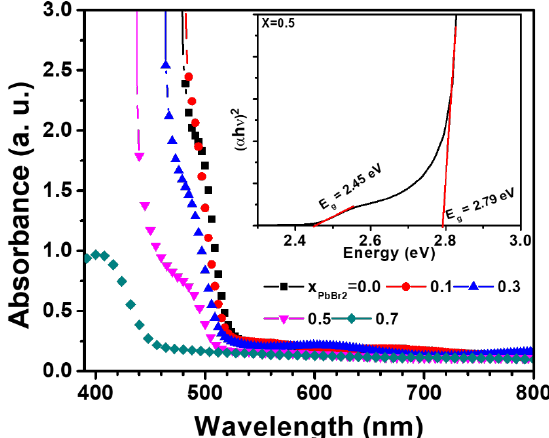
Figure 5. Absorbance of lead halide films deposited on glass substrates at x = 0, 0.1, 0.3, 0.5, and 0.7, respectively. The inset shows the Tauc plot of the lead halide coated at x = 0.5, revealing the optical bandgaps for PbI 2 (2.48 eV) and PbBr 1.2 I 0.8 (2.79 eV), respectively.